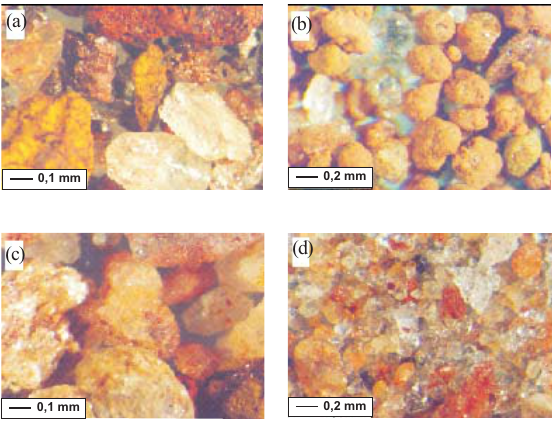
Figura 3. Fotografias de amostras de horizontes subsuperficiais: (a) areia fina, perfil FF1, podendo-se observar grãos de quartzo, nódulos ferruginosos e minerais escuros; (b) areia grossa, perfil FF1, com grande quantidade de agregados residuais; (c) areia fina, perfil CX2, com grãos de quartzo e um grão de mineral escuro abaixo e à direita; (d) areia grossa, perfil CX2, com domínio de grãos de quartzo e pequenos grãos de mineral escuro (do centro para o lado esquerdo da